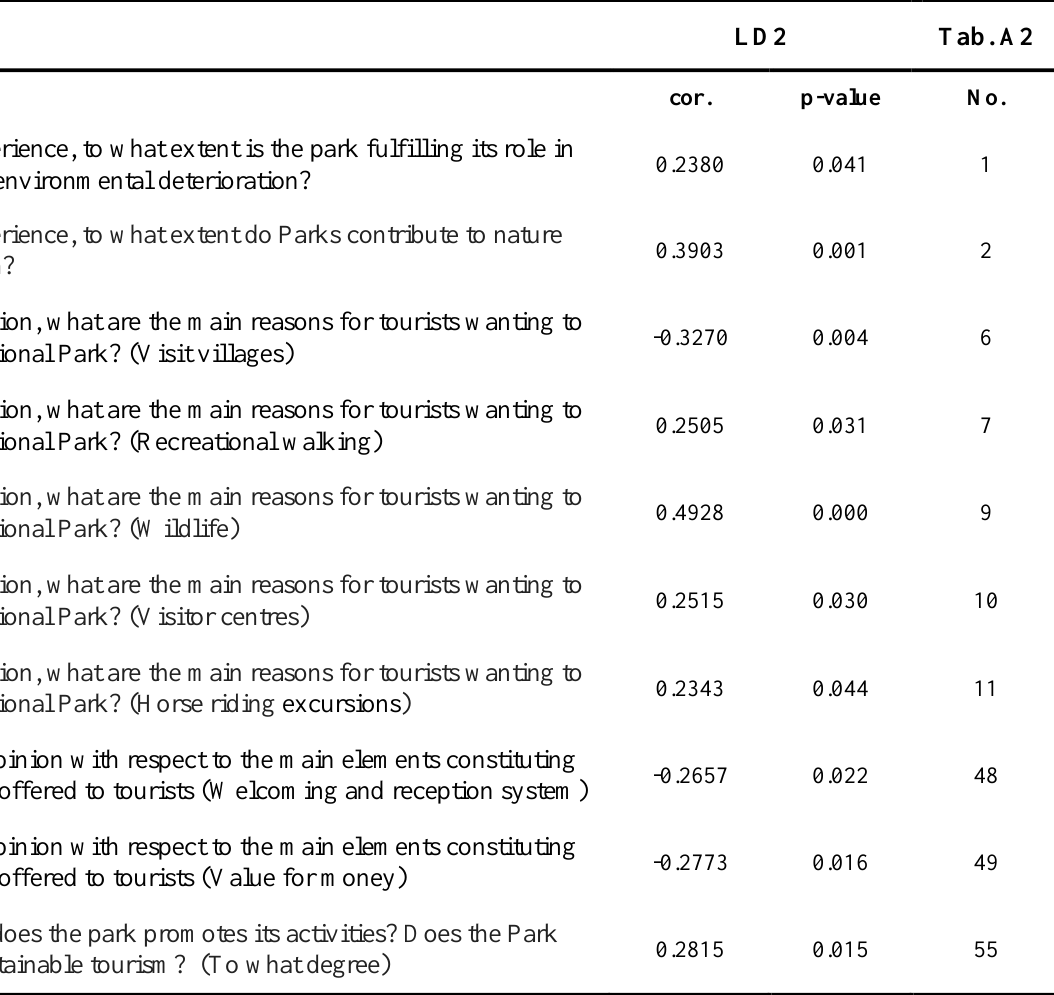
Table A4 Original variables (questions) which exhibit the higher correlation with LD2; for each question, correlation and p-values are shown, together with the relative question number reported in Tab. A2.